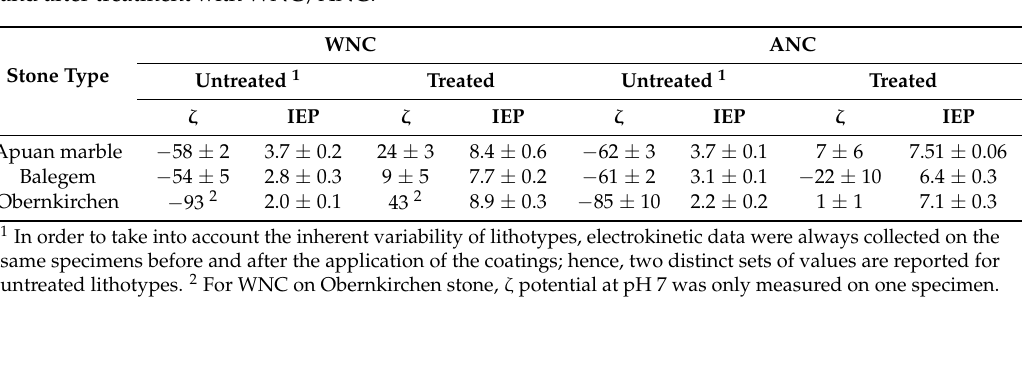
Table 6. Values of ζ potential at pH 7 (in mV) and isoelectric points (in pH units) of lithotypes before and after treatment with